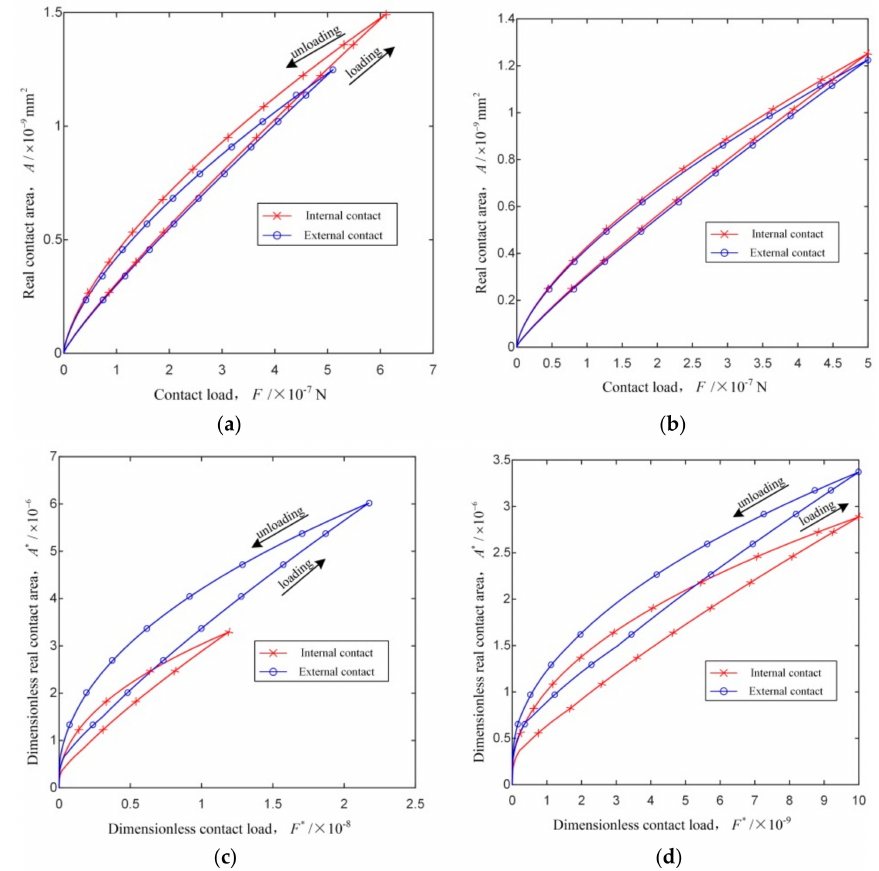
Figure 6. The relation between real contact area and contact load of two cylindrical surfaces in the second elastoplastic stage with di ff erent contact types with D = 1.5, G = 10 − 10 mm, R c1 = 100 mm and R c2 = 60 mm. ( a ) Unloading at the dimensional critical contact load; ( b ) unloading at a given dimensional contact load; ( c ) unloading at the dimensionless critical contact load; ( d ) unloading at a given dimensionless contact